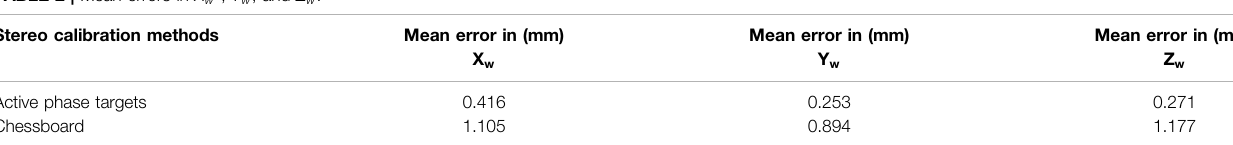
TABLE 2 | Mean errors in X w , Y w , and Z w .